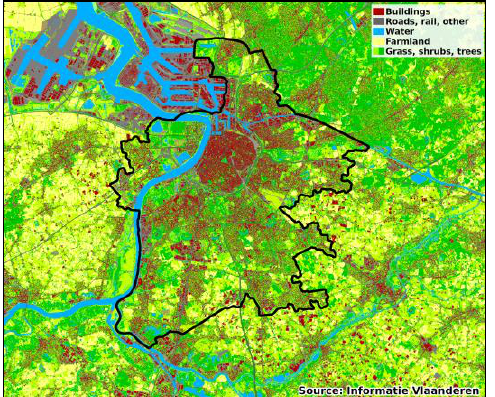
Figure 2. Land coverage in the greater Antwerp area 2015 including the Metropolitan Area demarcation [48,49].